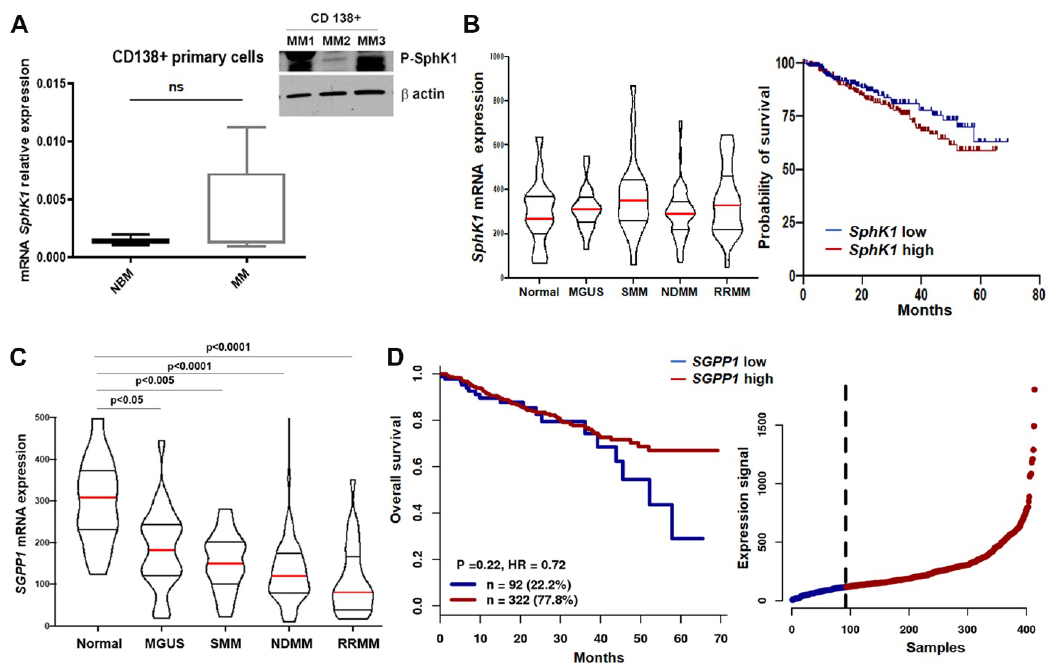
Figure 2. SphK1 and SGPP1 expression divergently correlate with MM patients’ progression. The mRNA expression levels of SphK1 in CD138+ primary cells of MM patients ( n = 7; see MM 4-10 in patient/normal donors characteristics Table S1) compared with normal donors ( n = 3; see ND 1-3 in patient/normal donors characteristics Table S1) (left panel); unpaired t-test with Welch’s correction showed differences between NBM vs. MM were not significant (ns; p = 0.187); P-SphK1 protein levels as measured by WB (Original data in Figure S6) in (left panel) in three CD138+ primary cells of MM patients (see MM 1-3 in patient/normal donors characteristics Table S1) (right panel) ( A ); Transcriptome analysis of the GSE6477 dataset showing SphK1 mRNA expression in different stages of the disease: Monoclonal gammopathy of undetermined significance (MGUS; n = 22), smoldering myeloma (SMM; n = 24), newly diagnosed MM (NDMM; n = 73), and relapsed refractory MM (RRMM; n = 28) were compared to normal (N) ( n = 15), (Tukey’s multiple comparison test shows no significance among the 6 groups) (left panel) and SphK1 mRNA expression analysis of newly diagnosed MM patients (before treatment) ( n = 414) using GSE4581 dataset showing probability of survival for low expression (blue, n = 207) and high expression (red, n = 207) (Log-rank test showed no significant difference between groups p = 0.3086) (right panel) ( B ); Analysis of mRNA SGPP1 expression in MM patients using GSE6477 dataset in different stages of plasma cell neoplasm (same groups as in B left panel) using Tukey’s multiple comparison test shows significance between normal and MGUS ( p = 0.03), normal and SMM ( p = 0.0015), normal and NDMM ( p < 0.0001), and normal and RRMM ( p < 0.0001) ( C ); Overall survival based on SGPP1 mRNA expression (low in blue, n = 92 and high in red, n = 322) ( p = 0.22) in newly diagnosed MM patients using Arkansas database and GSE4581 dataset (left panel) and expression signal of SGPP1 in the patient cohort (right panel) ( D ). In contrast, analyzing gene expression arrays from the GSE6477 dataset of different stages of MM, we found progressive and significant repression of SGPP1 expression compared to normal plasma cells, and showed more profound inhibition of SGPP1 expression in relapsed MM patients (Figure 2C). Moreover, analysis of the GSE4581 dataset from the Arkansas myeloma database showed that, although there was no difference in survival through the first 29 months, afterwards (particularly from 34 months on), as the patients’ disease progressed, there was a strongly significant association of high SGPP1 levels with longer survival ( p = 0.008; HR = 0.1506; n = 121)